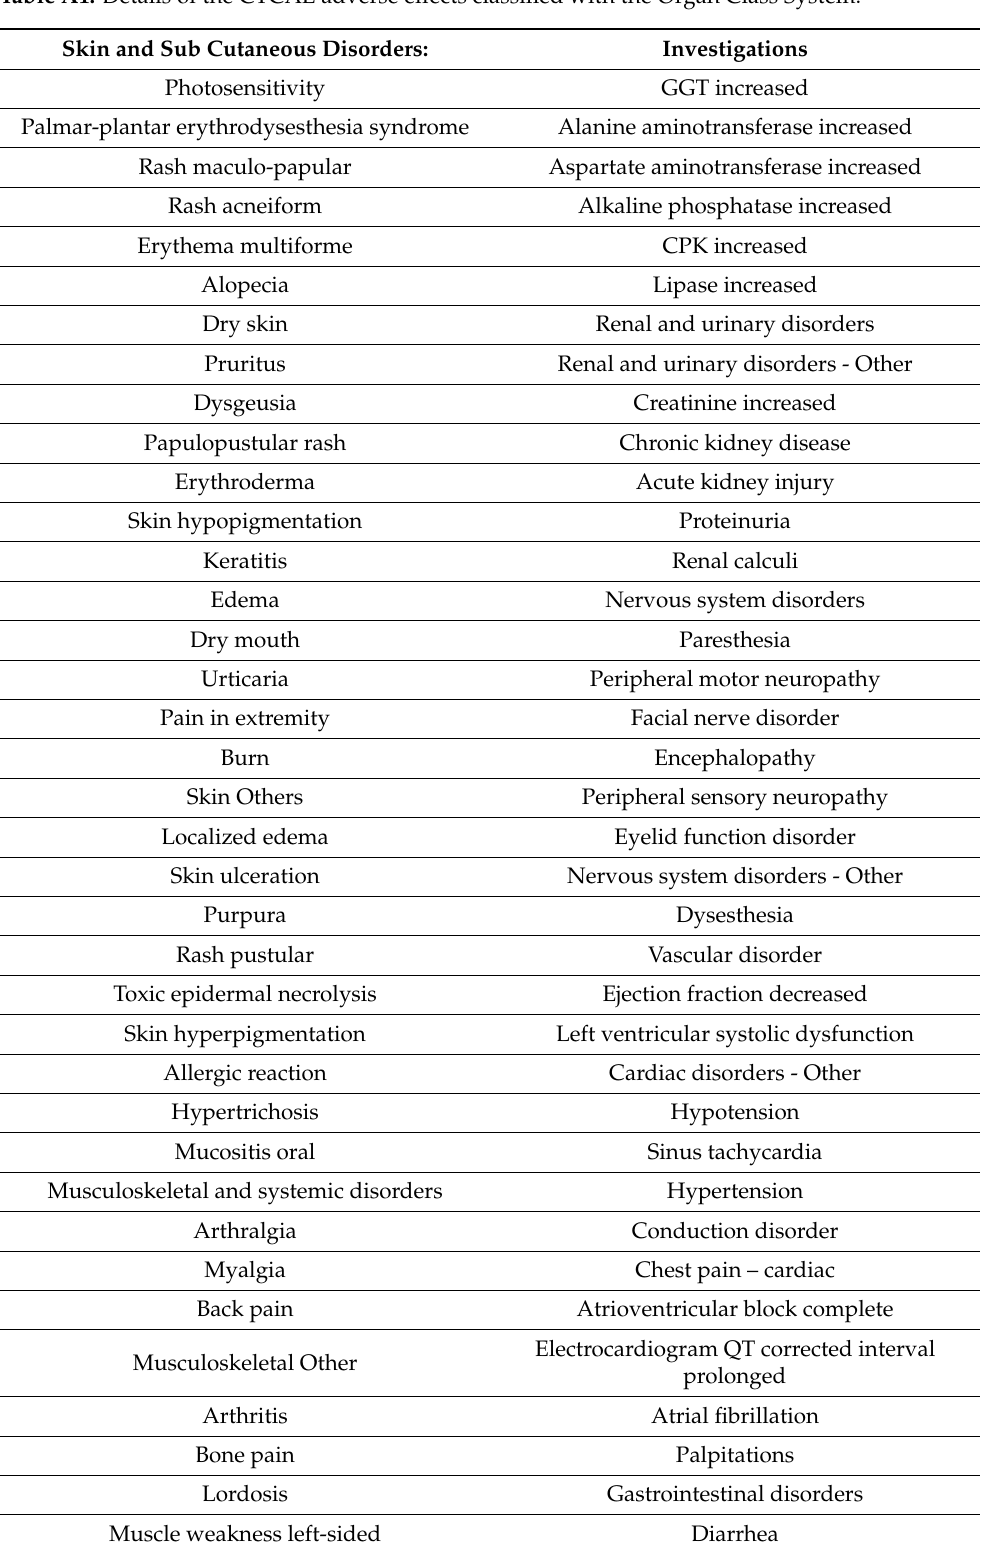
Table A1. Details of the CTCAE adverse effects classified with the Organ Class